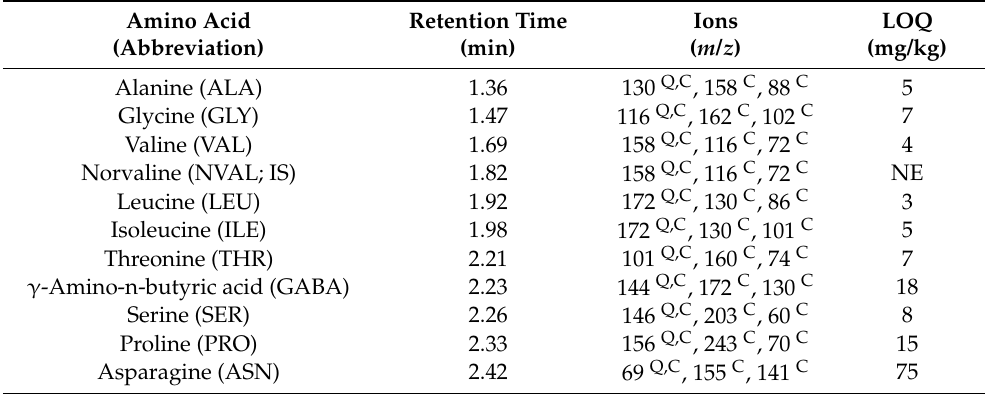
Table 1. GC-MS data and limits of quantification for the studied free amino